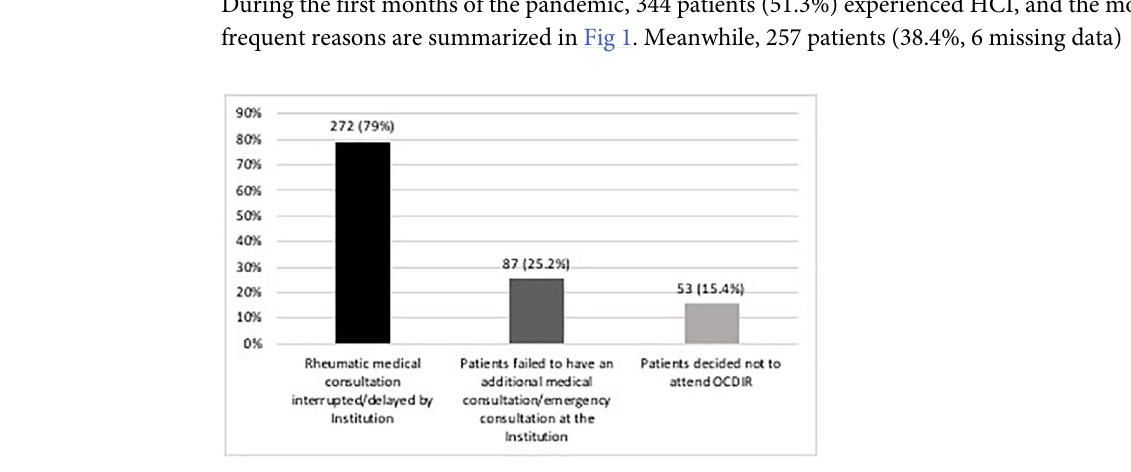
Fig 1. Distributions of the reasons referred by 344 patients with